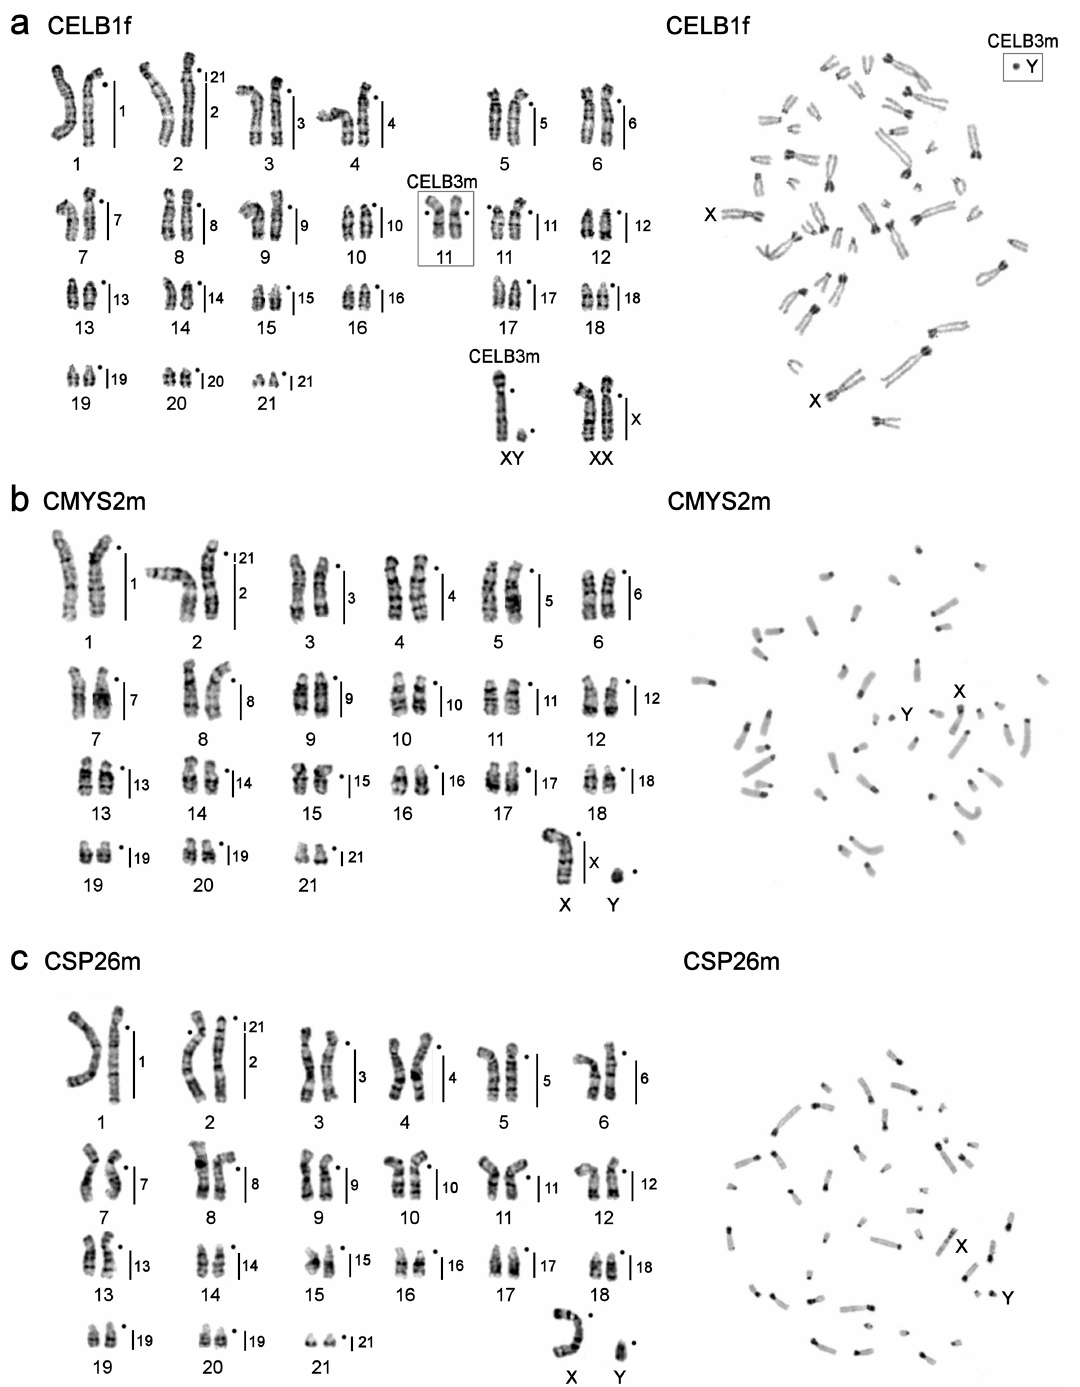
Figure 5. G-banded karyotypes (on the left) and C-banded metaphases (on the right) of the studied specimens with 2n = 44: ( a ) C. elburzensis 1f (CELB1f) and C. elburzensis 3m (CELB3m); ( b ) C. m. mystax 2m (CMYS2m, the karyotype was presented previously in [48]); ( c ) Calomyscus sp. 26m (CSP26m) , vertical black lines and figures on the right of G-banded chromosomes show localization of Calomyscus sp. 17m probes. Black dots mark the position of centromeres. In C-banding photos sex chromosomes (X and Y) are shown.